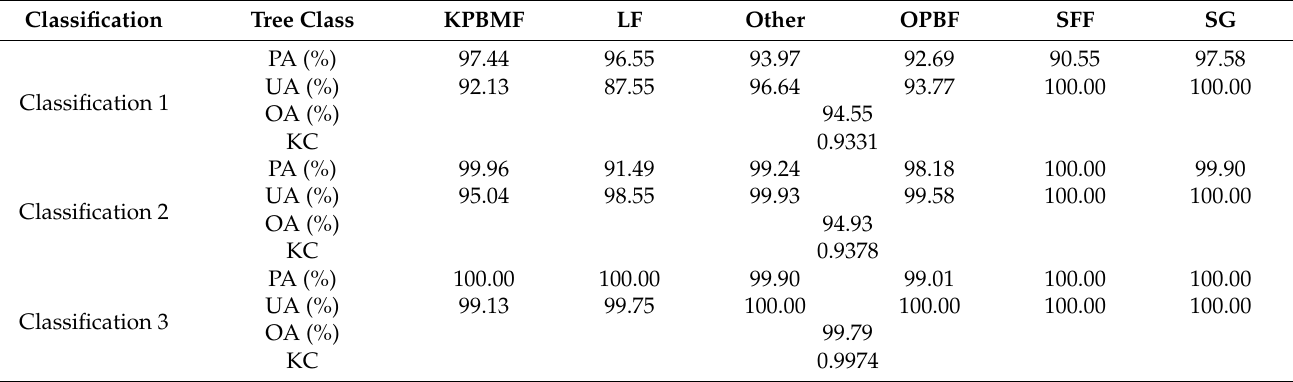
Table 1. Accuracy of tree species classification.